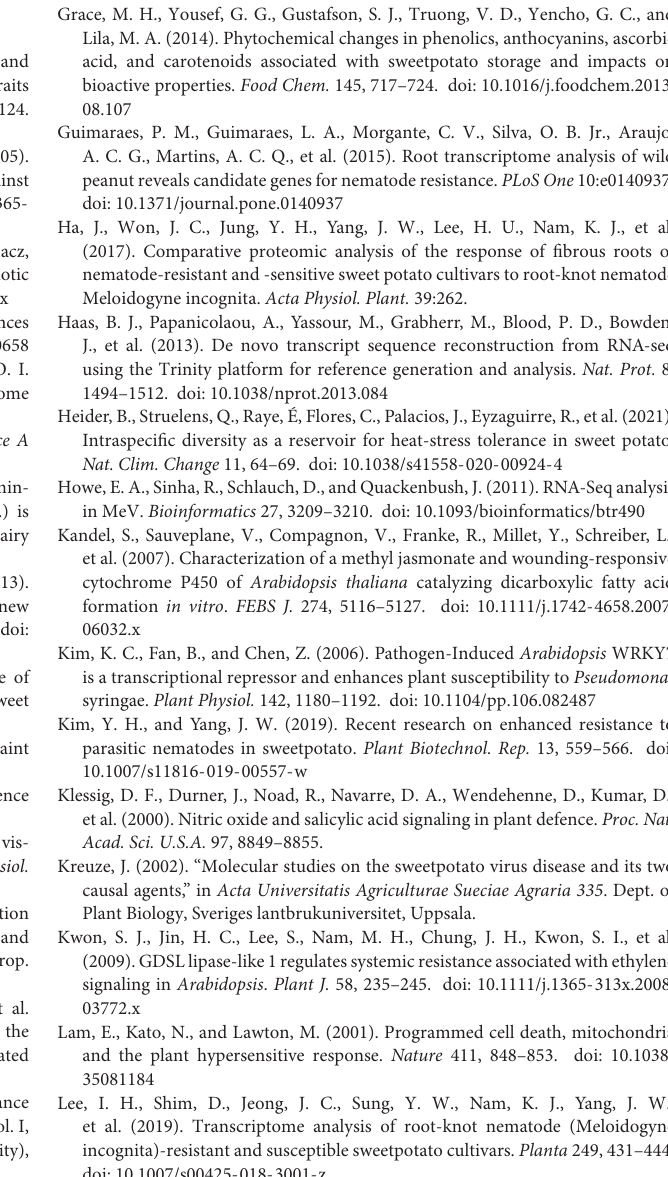
Supplementary Figure 1 | Volcano plots showing pairwise comparisons of transcript levels across samples. Log 2 fold change (logFC) between two samples is plotted on the Y -axis, and log 2 average of the counts normalized by size factor is shown on the X -axis. Red dots indicate transcripts with logFC significantly > 2 or lower than –2. Black dots indicate transcripts with logFC was between –2 and 2. DHM, Dahomi; DJM, Danjami; PWM, Pungwonmi; SHM, Shinhwangmi; JHM, Juhwangmi; YM, Yulmi; RCs, resistant cultivars; SCs, sensitive cultivars; C, control; T,